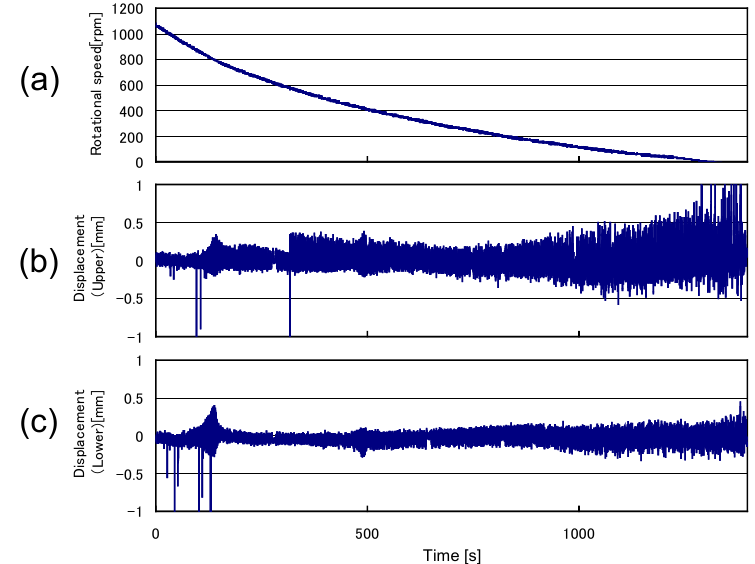
Figure 11. Free-run experimental results in the case of a fixed stator, representing ( a ) a natural rotation decay curve, ( b ) displacement at an upper position of the rotor and ( c ) displacement at a lower position of the rotor.